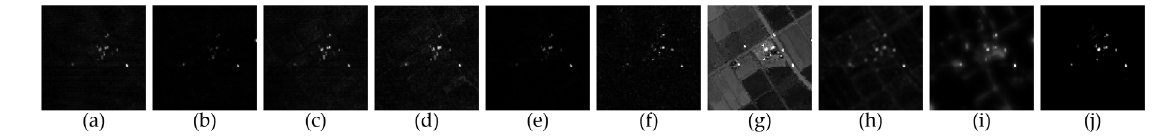
Figure 10. The detection results of different methods on the MUUFL Gulfport dataset: ( a ) RX; ( b ) LRX; ( c ) LSMAD; ( d ) LSDM–MoG; ( e ) CDASC; ( f ) 2S–GLRT; ( g ) BFAD; ( h ) SSFSCRD; ( i ) AED; ( j ) SCDF.